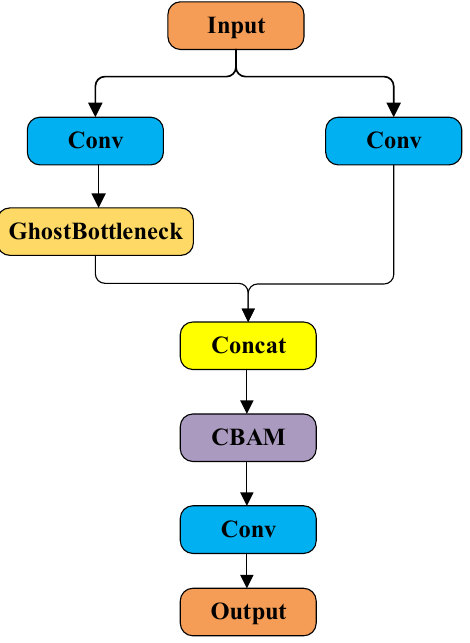
Figure 5. AC3Ghost module Structure.